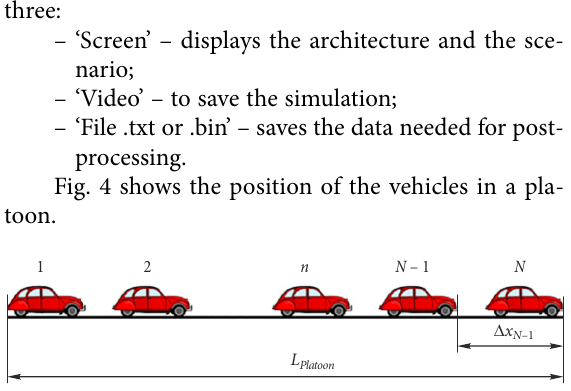
Fig. 4. Positions of the vehicles in the platoon